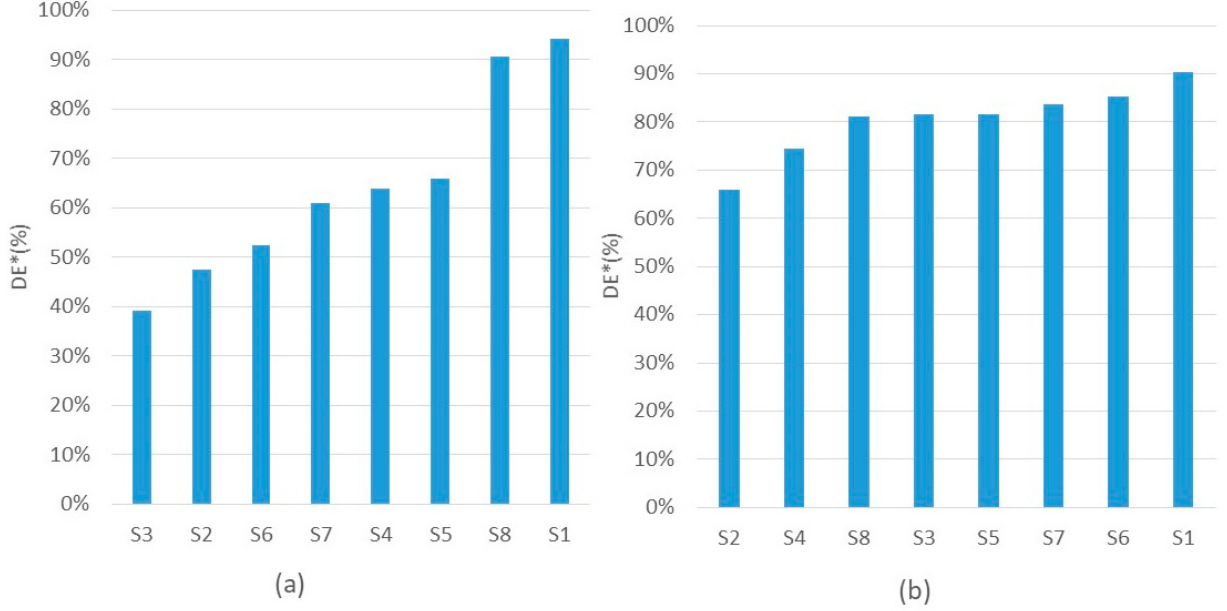
Figure 4. De-inking effect from the small-scale experiment. ( a ) CIELAB values of the small-scale samples. ( b ) De-inking rate by sorting the un-deinked flakes. From the color measurement of the de-inking effect, CTAB at pH 12 (Sample S1) was measured with the best performance from both measurements of a de-inking effect of 94.19% and 90.26%, respectively. In the colorimeter analysis, sample S8 showed the second-best de-inking performance of 90.63%. With the flake sorting method in Figure 4b, samples S6 and S7 showed the second better de-inking result. From the small-scale experiment, it can be concluded that applying the macroemulsifier DA850, present in samples S6, S7, and S8, can enhance the de-inking performance. However, the influence of different pH values on the de-inking effect of the nonionic surfactant was not evident.